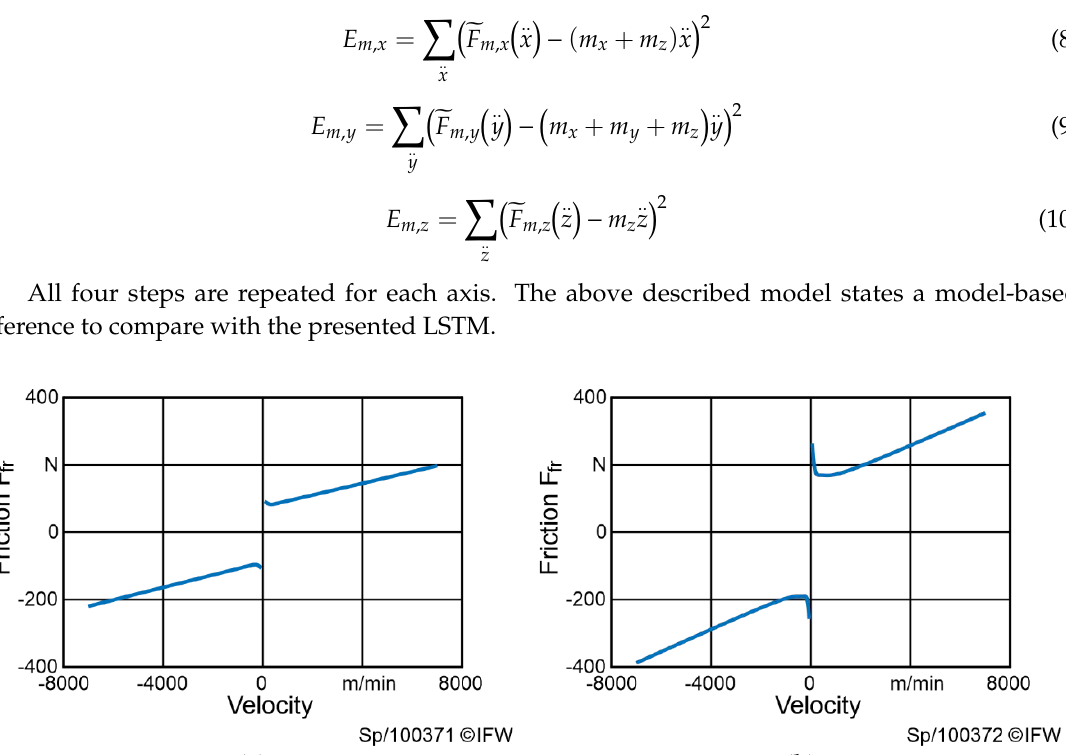
Figure 1. Model-based approach: ( a ) complete model; ( b ) X -axis submodel. To parametrize the model, axis movements are performed without tool engagement.